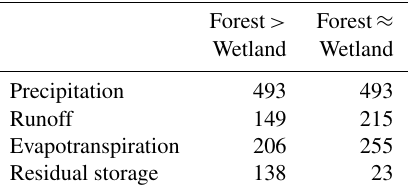
Table 1. Annual precipitation (2008–2019), basin runoff (1996– 2015; Connon et al., 2014; Haynes et al., 2018), evapotranspiration (2013–2016; Warren et al., 2018), and residual storage values are presented (millimetres per year) for two distinct transitional land- scape stages at Scotty Creek, namely a landscape dominated by forest and a patchwork landscape of near-equal forest and treeless wetland land covers. Forest > Forest ≈ Wetland Wetland Precipitation 493 493 Runoff 149 215 Evapotranspiration 206 255 Residual storage 138